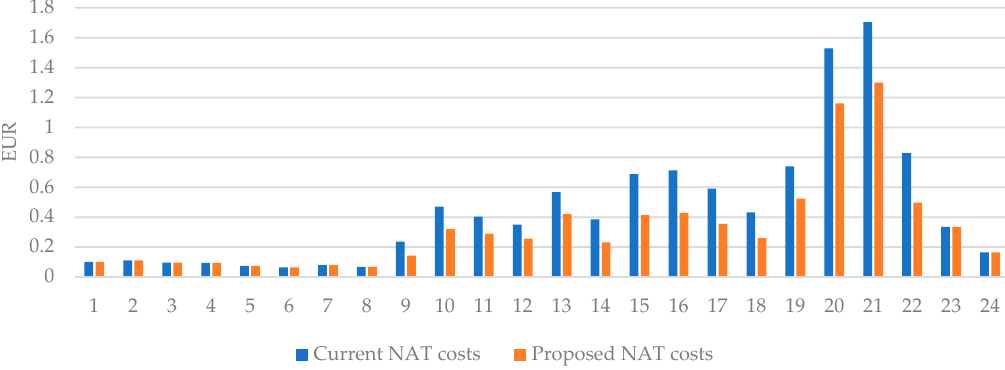
Figure 8. Comparison between the sum of hourly NAT costs for a 3-period Time-of-Use rate (3.45–20.7 kVA) in a BaU scenario and in the proposed business model during the 6-month trial period. Source: Authors’ own elaboration.